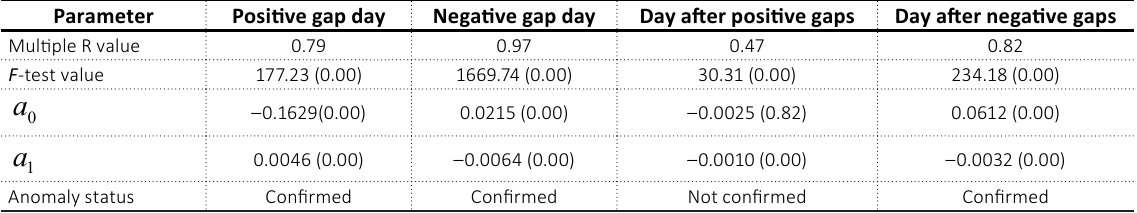
Table A6. Modified CAR approach, the case of the UX index over the period